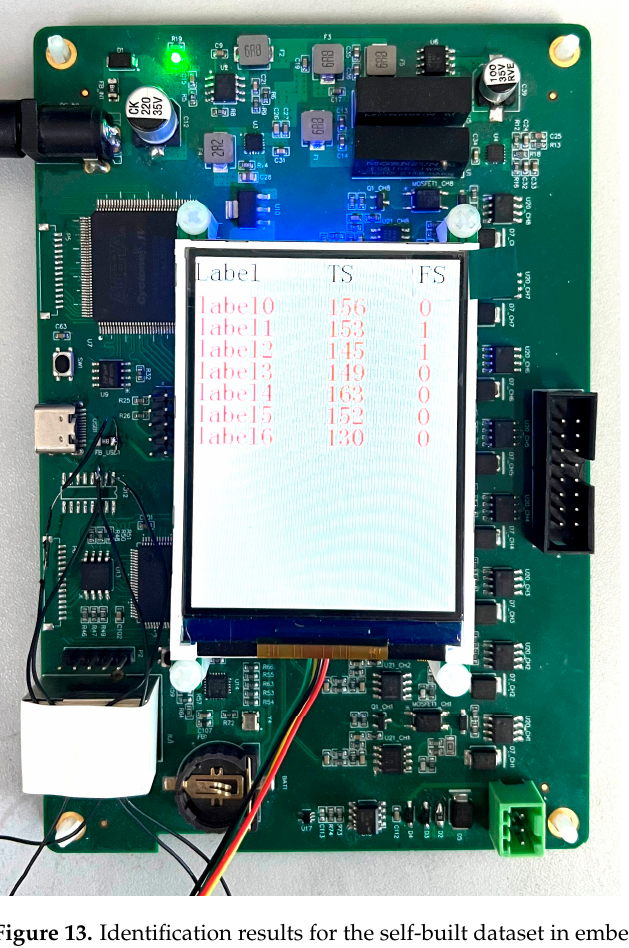
Figure 13. Identification results for the self ‐ built dataset in embedded systems.